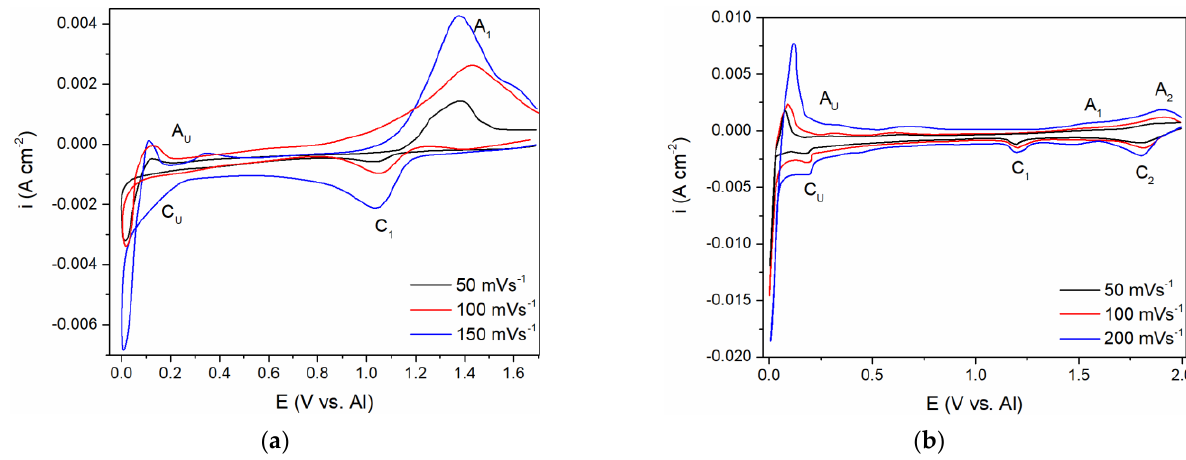
Figure 5. Cyclic voltammograms recorded on glassy carbon (GC) WE with different scan rates: ( a ) in equimolar AlCl 3 + NaCl + anodically dissolved V; T = 200 °C; ( b ) in equimolar AlCl 3 + NaCl + vanadium(III)chloride, T = 200 °C.